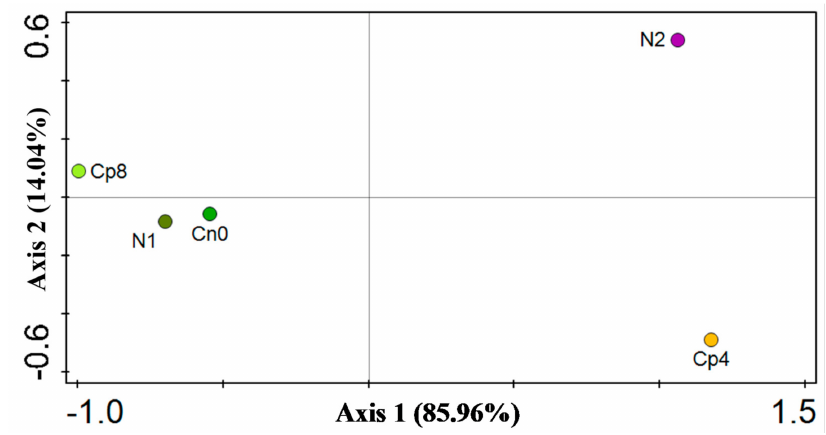
Figure 4. PCoA analysis showing the β diversity of chemotaxis genes within the fertilized and unfertilized maize rhizosphere soil samples Cn0 (control), Cp8 (8 tons/ha compost manure), Cp4 (4 tons/ha compost manure), N2 (120 kg/ha inorganic fertilizer), and N1 (60 kg/ha inorganic fertilizer).